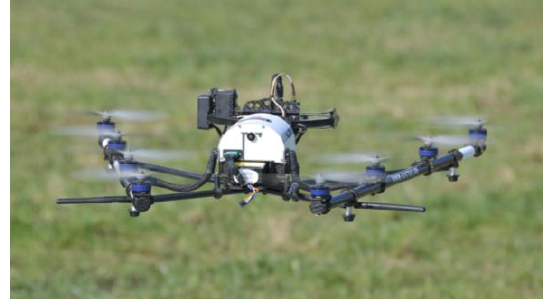
Figure 1. UAV system Falcon 8 during data acquisition.